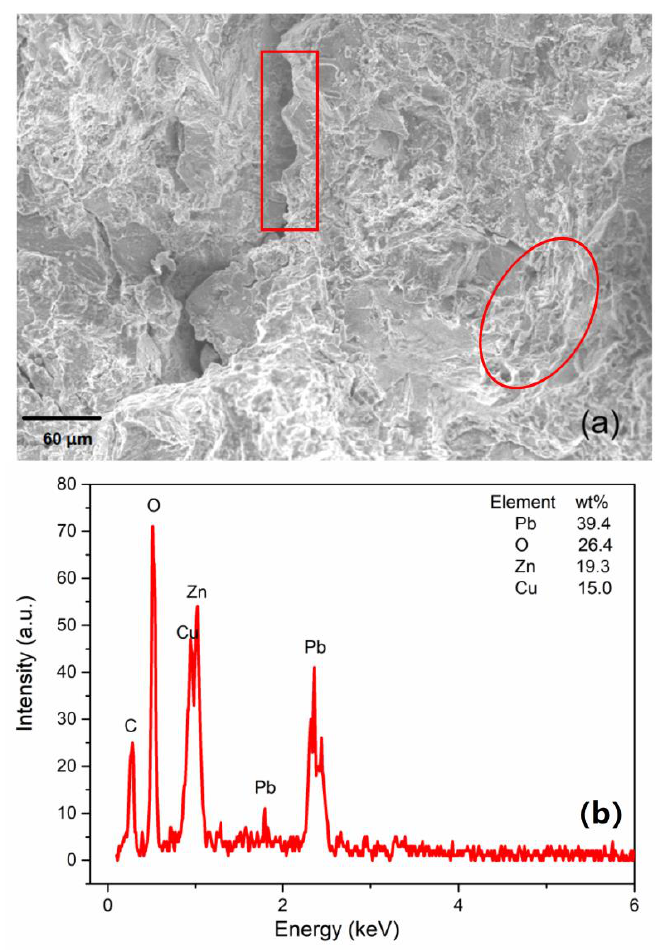
Figure 3. Local magnified SEM micrographs ( a ) and EDS spectrum ( b ) of the fracture surface.